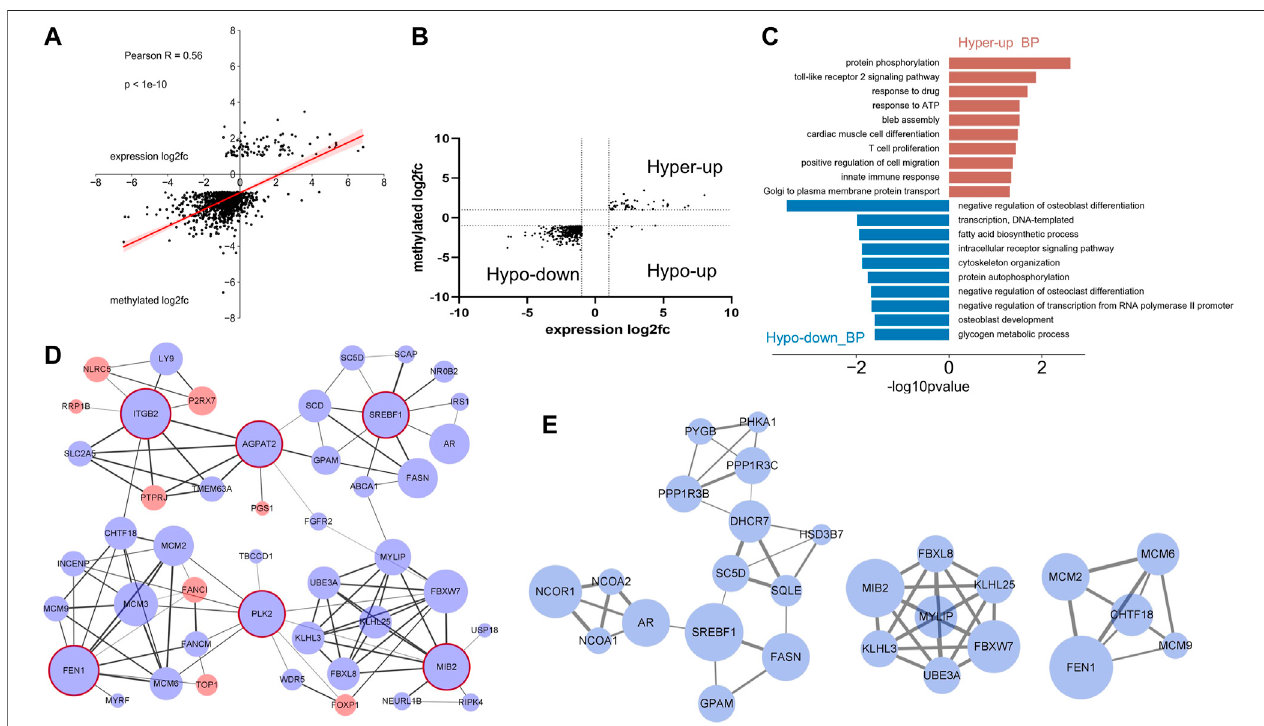
FIGURE 5 | Conjoint analysis of m6A-RIP-seq and RNA-seq data of the LPS-treated samples and control. (A) Dot plot of log2 fold change of mRNA expression against log2 fold change of differential m 6 A methylation. (A) Positive correlation was shown (Pearson r = 0.56). (B) Distribution of genes with signi fi cant changes in both m 6 A and mRNA levels in LPS-treated group compared with adjacent normal group (fold change > 2, p < 0.05). (C) Gene ontology analysis of biological process of the differentially expressed and m 6 A methylated genes. (D) Graph of the protein – protein interaction network of the genes [mentioned in (B) ] conducted by Cytoscape software. Red and blue circles represent the up- and down-expressed genes, respectively. The circles with red edge line were hub genes. Different width values of the lines between two nodes indicated different combined scores, and the wider line represents higher score. (E) Modules of the PPI network.